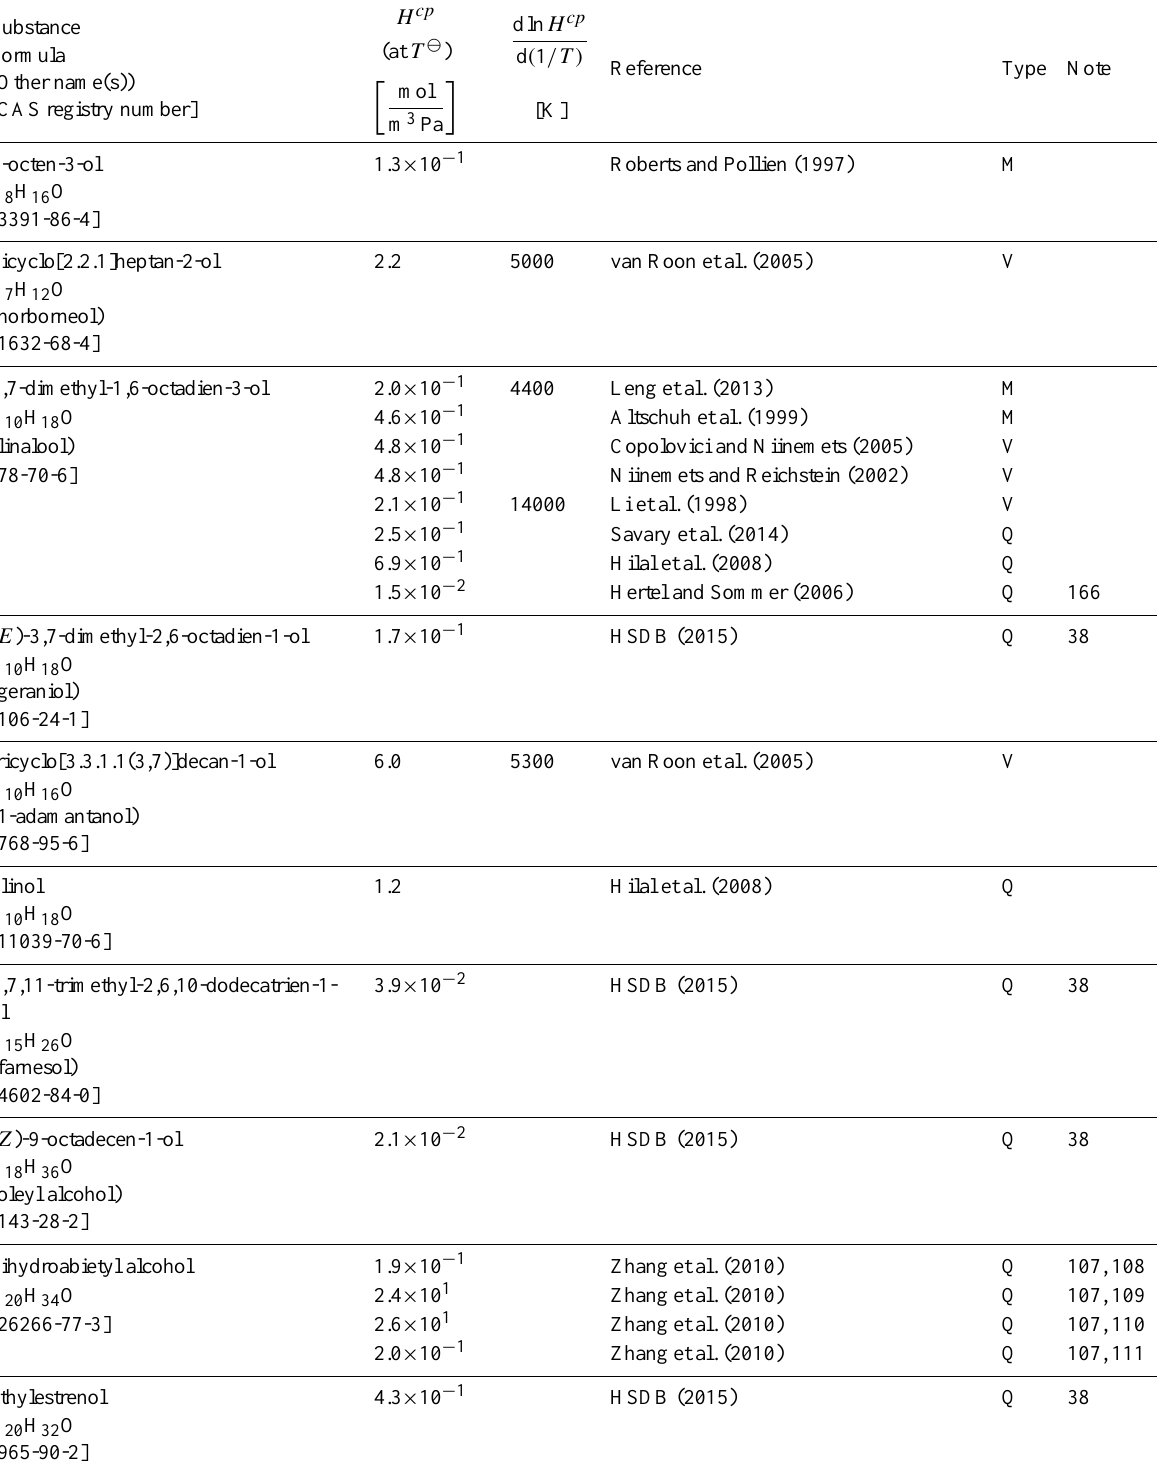
Table 6: Henry’s law constants for water as solvent